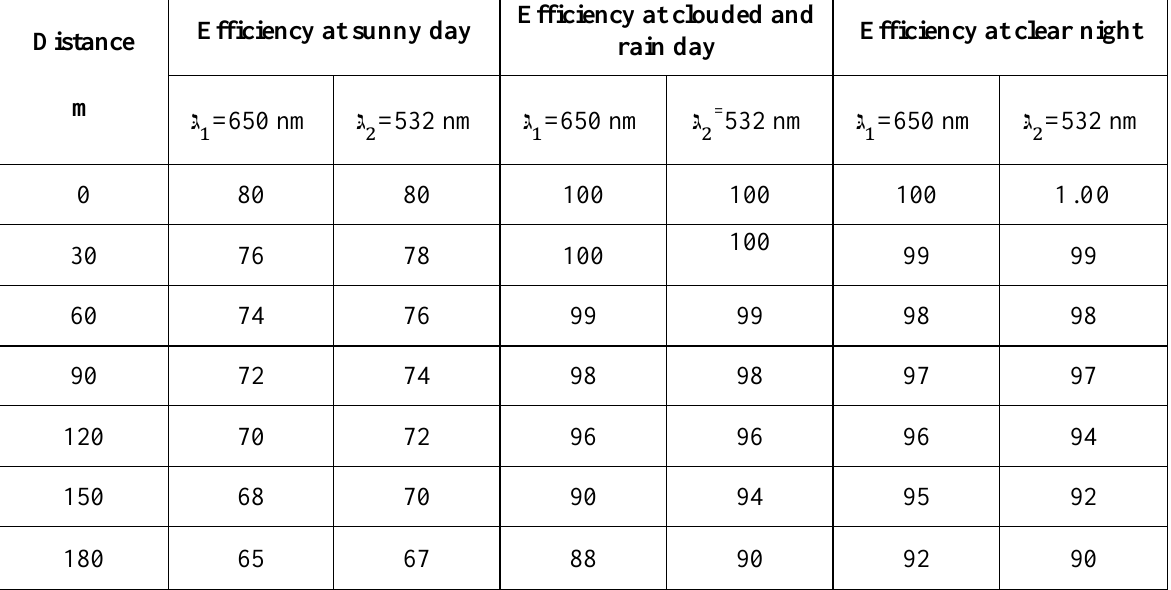
Table 1: The system efficiency for different distances. Efficiency at sunny Distance